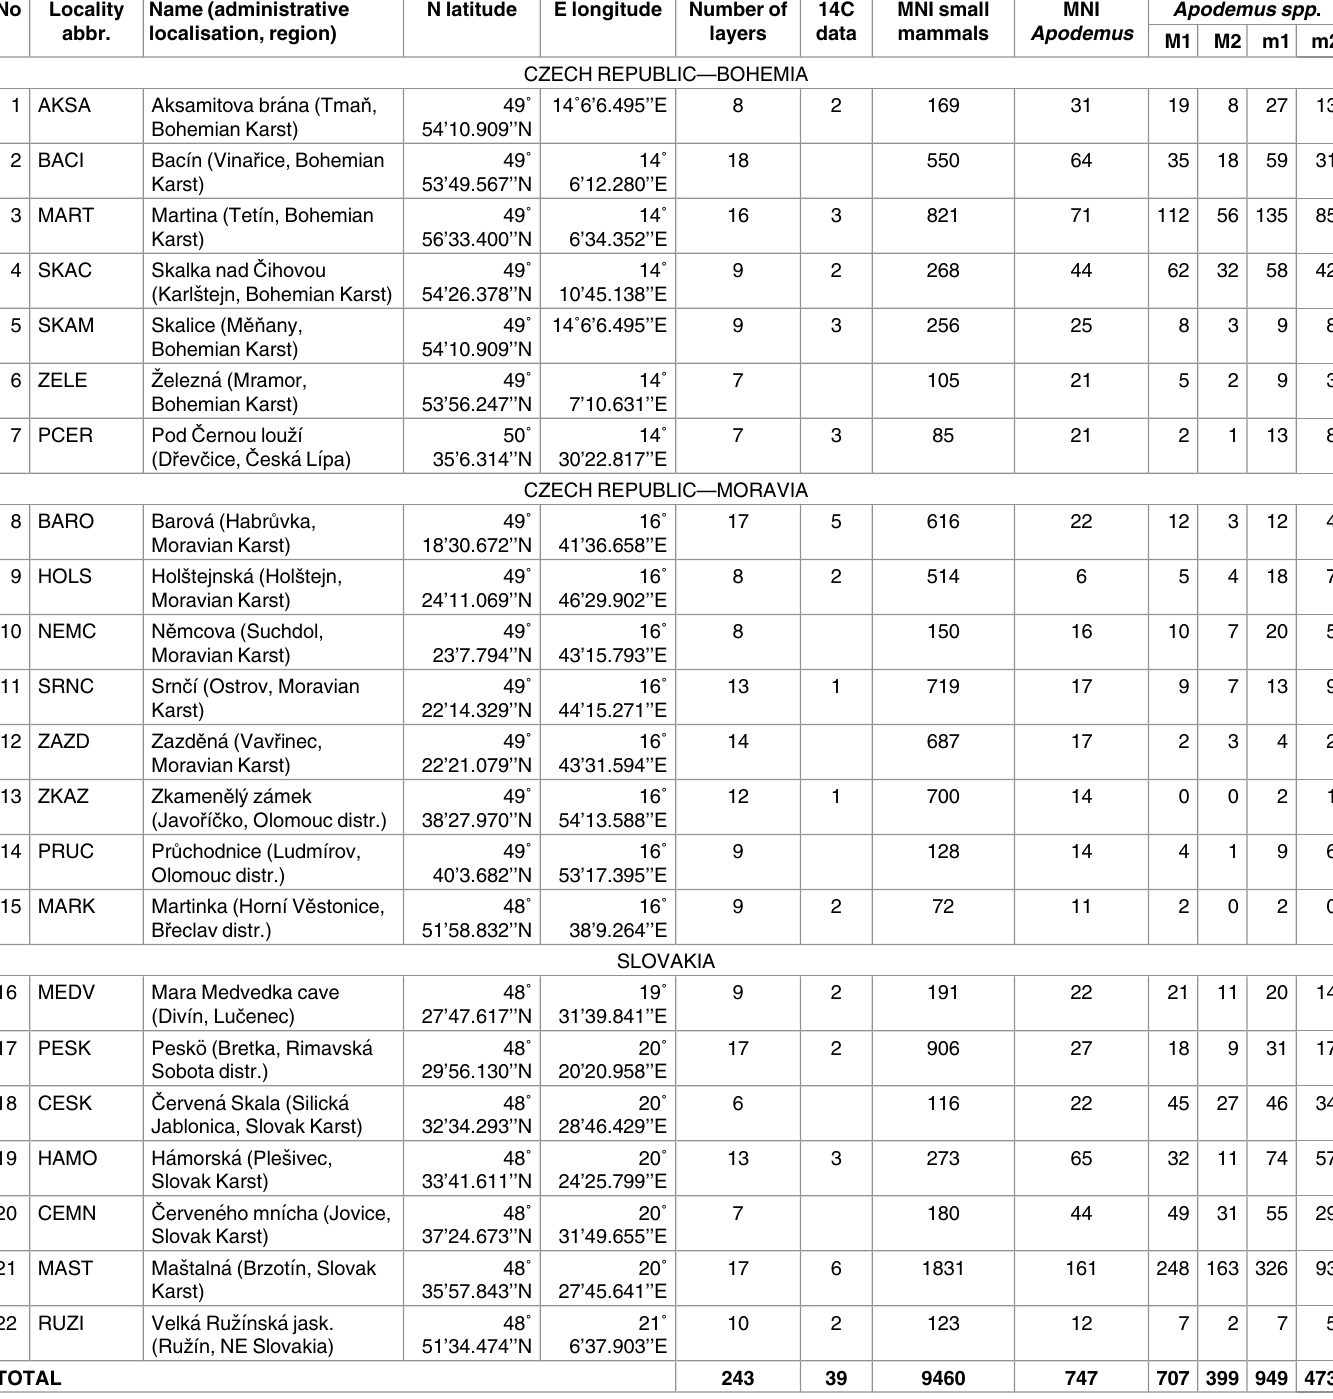
Table 1. Source sections of the material examined in this study. No Locality